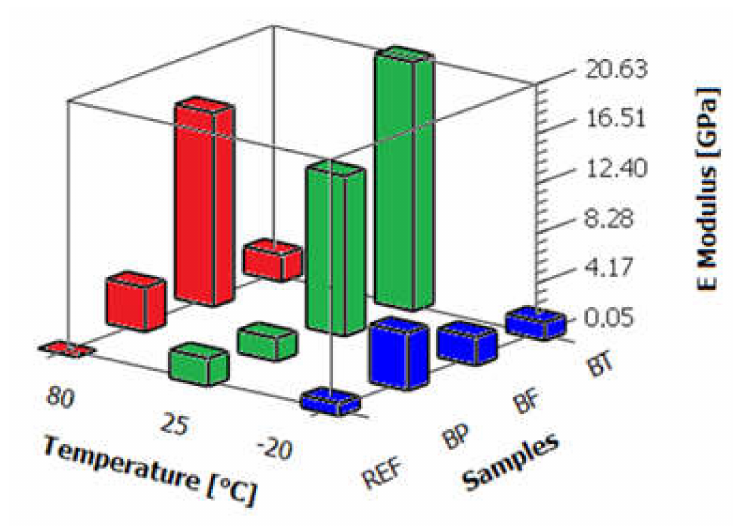
Figure 6. Young’s E modulus versus temperature for sample EP (REF) and composites EP reinforced with basalt powder (BP), basalt fibre (BF) and basalt textile (BT) (Table A1).